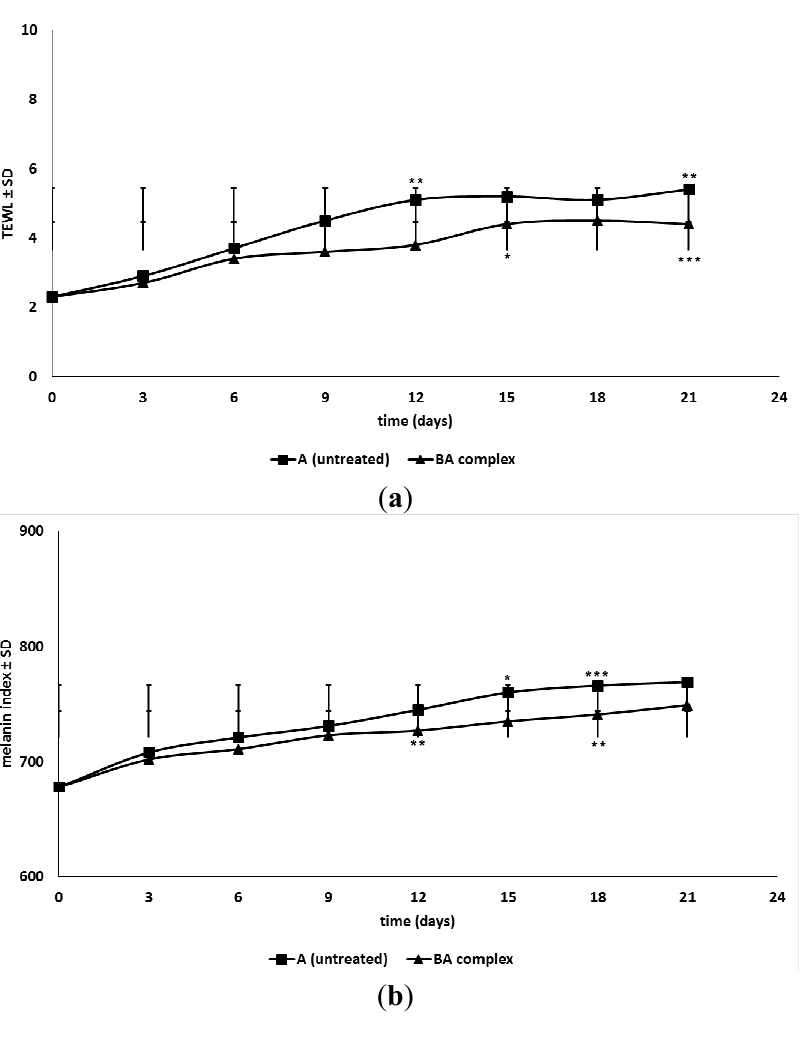
Figure 10. ( a ) Transepidermal water loss (TEWL); ( b ) Melanin index; and ( c ) Erythema evaluation on two experimental groups after 21 days of daily